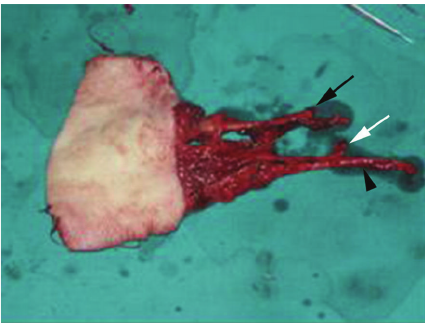
Figure 5: The free composite dorsalis pedis-extensor hallucis brevis flap (black arrow: dorsalis pedis artery and vein, white arrow: extensor hallucis brevis tendon, and arrowhead: saphenous vein).